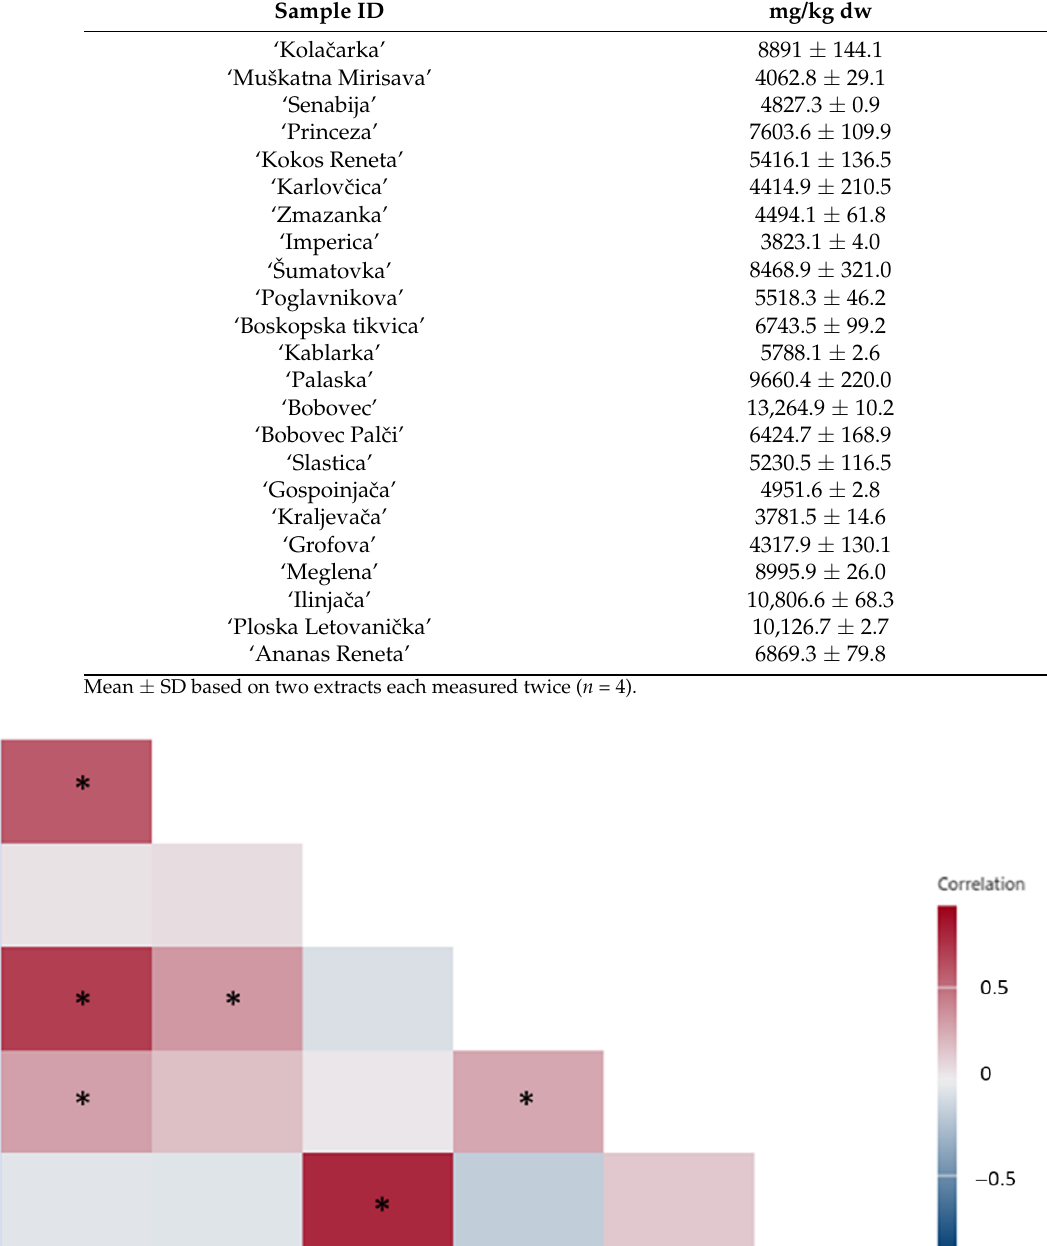
Table 1. Total polyphenol content (mg/kg dw) in traditional apple varieties.